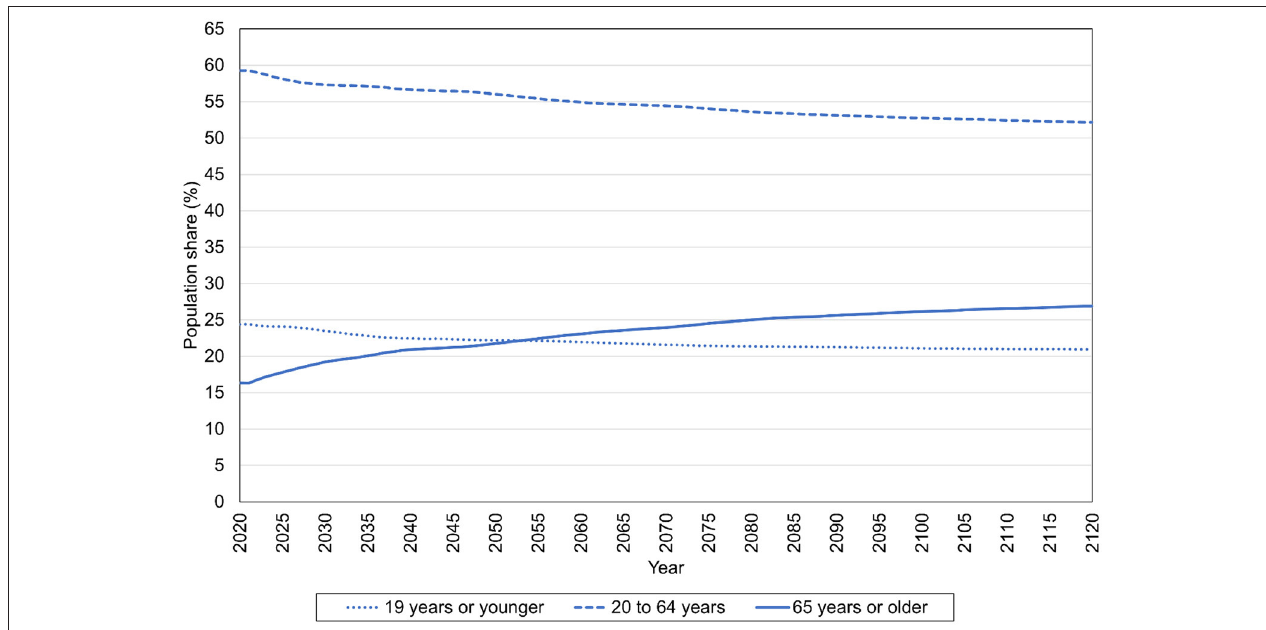
FIGURE 1 | Population shares of different age groups, 2020–2120, Medium scenario, Australia (%).